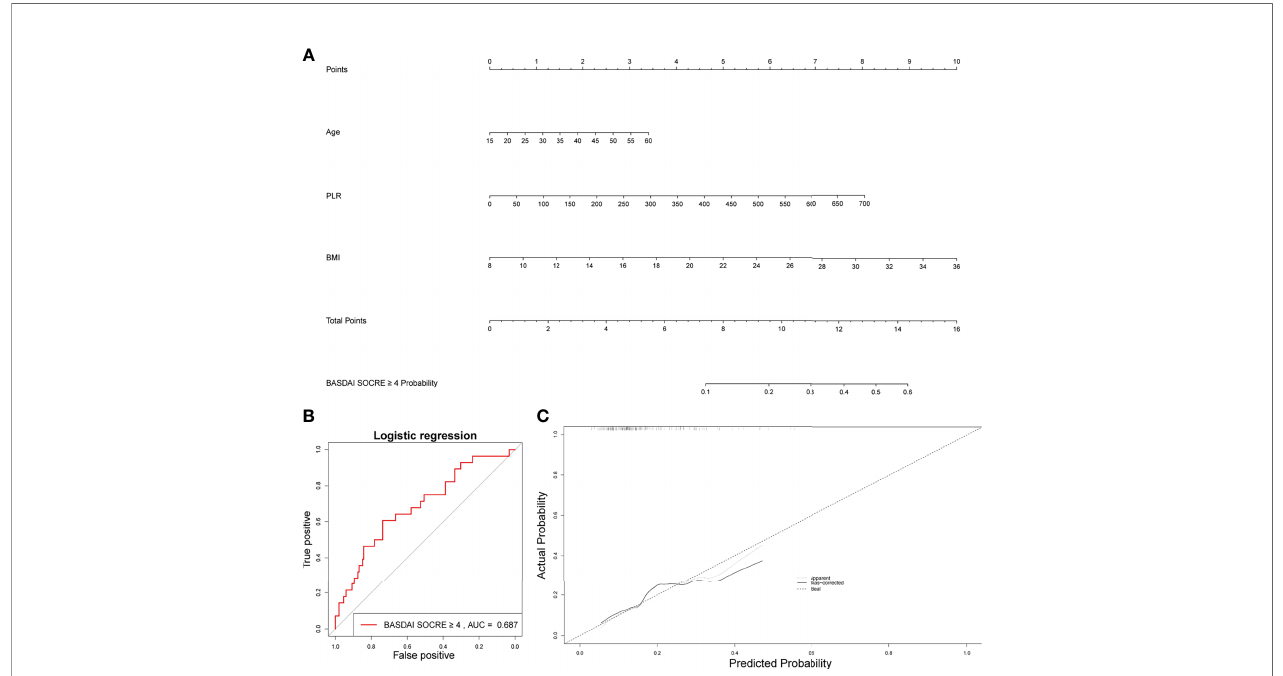
FIGURE 6 | Establishment of a nomogram for activated AS patient prediction. (A) The nomogram for activated AS patient prediction. (B) AUC of the nomogram based on the 3 characteristics. (C) Calibration curves for predicting activated AS patient